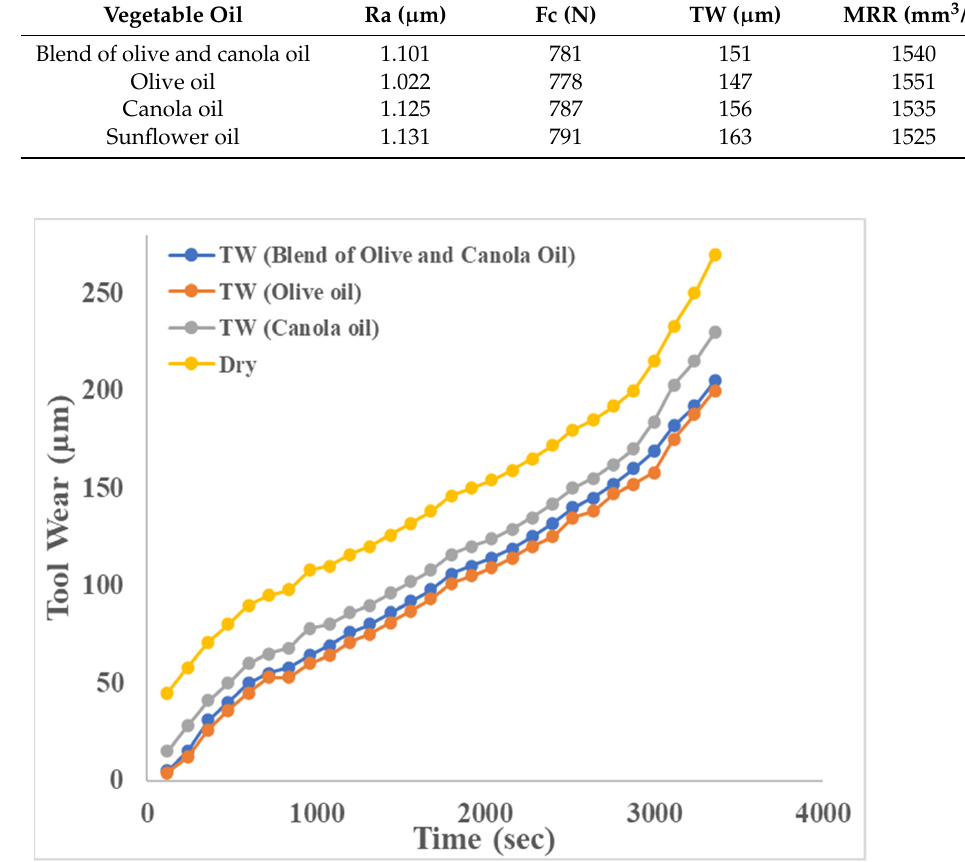
Figure 11. Tool wear progression curve under different machining conditions.